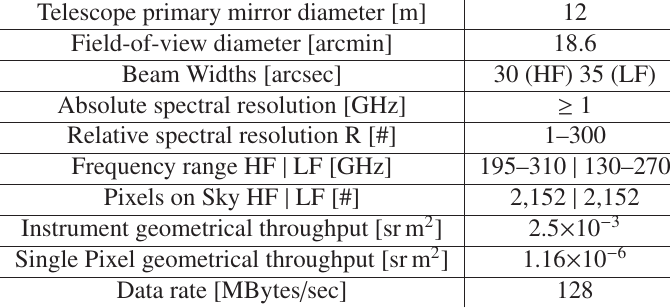
Table 1. Main characteristics of CONCERTO at